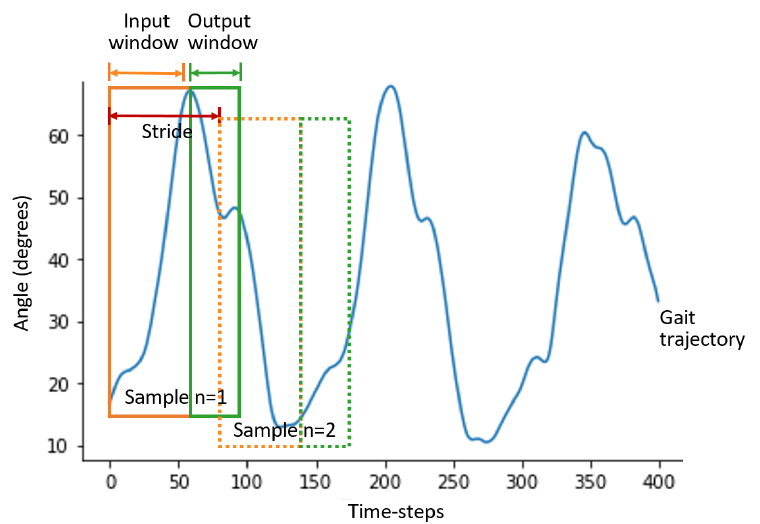
Figure 1. Illustration of the sliding window method. Continuous gait trajectories are used to generate input and output windows for training the model using the sliding window method. Each pair of input and output windows forms one sample. Several samples can be generated from one continuous gait trajectory by sliding the window for a specified distance, also known as stride